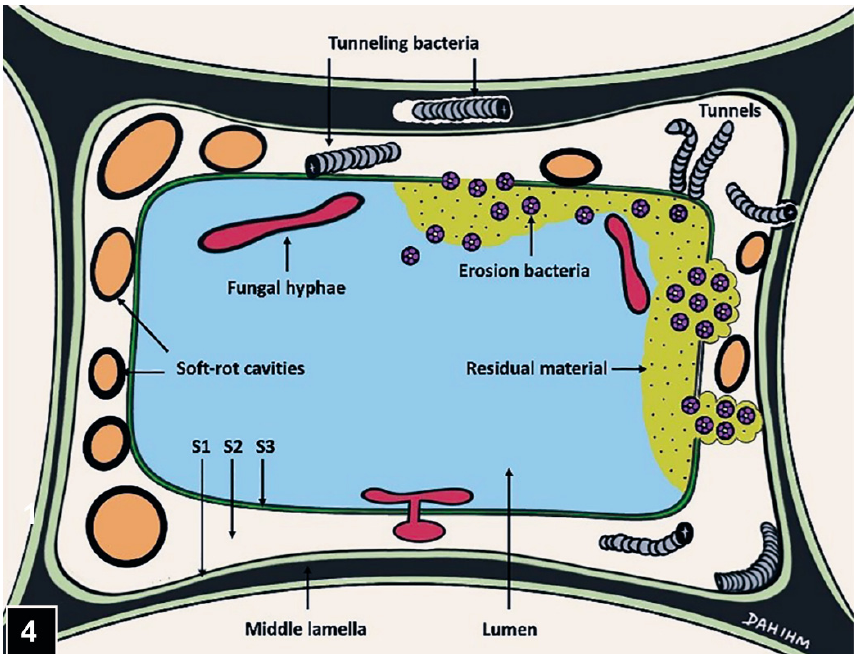
Figure 4. A diagram showing the micromorphological patterns produced during attack of a tracheid wall by soft-rot fungi and tunnelling and erosion bacteria. The diagram from Kim and Singh (2000) IAWA J. is kindly re-drawn by DahIhm Kim.